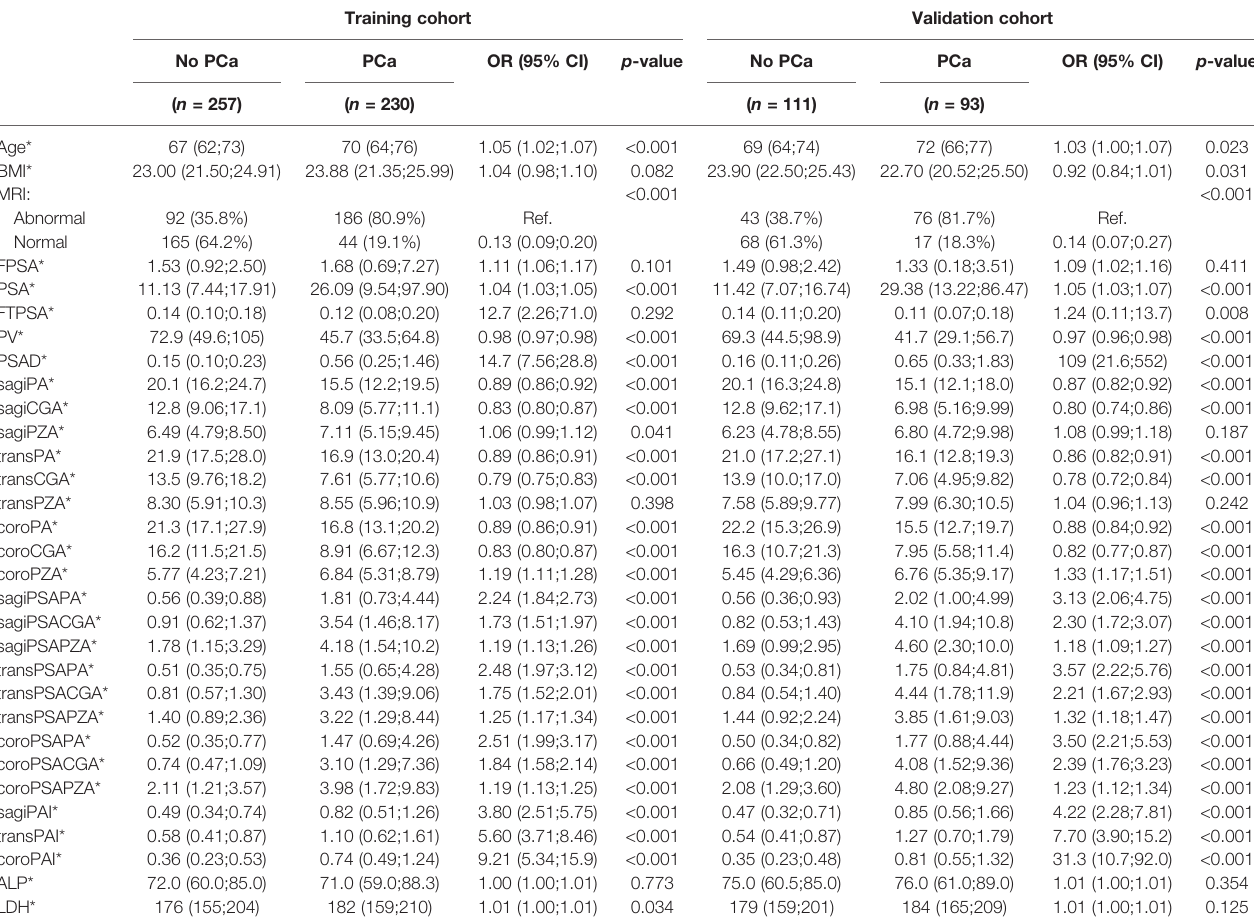
TABLE 1 | Clinical characteristics of patients before the prostate biopsy. Training cohort Validation